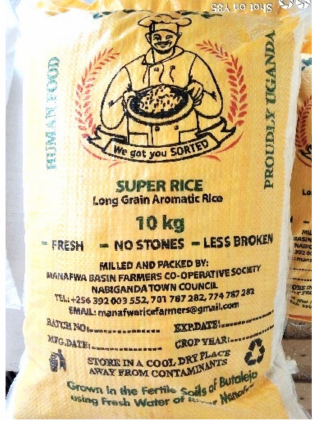
Figure 8. NARORICE-1 branded and marketed as Supa by Manafwa Basin Farmers’ Cooperative Society in Doho, Butaleja